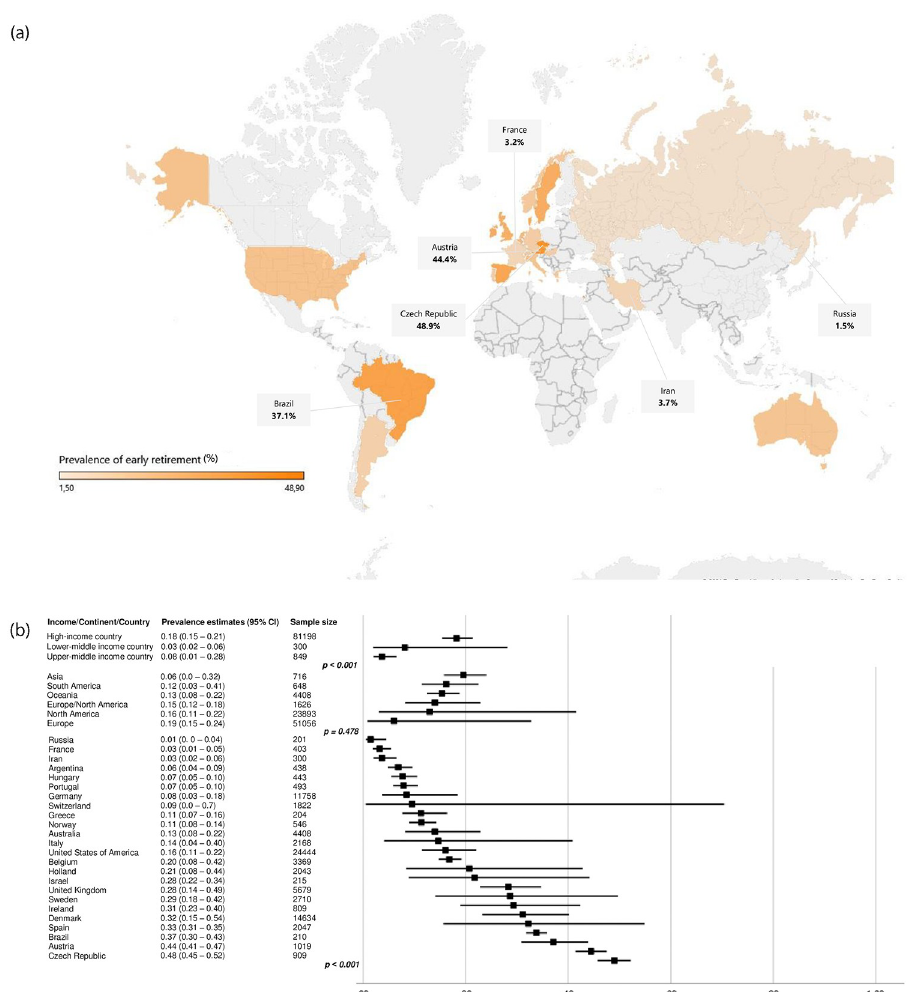
Fig 5. Prevalence of early retirement (%) according to geographical